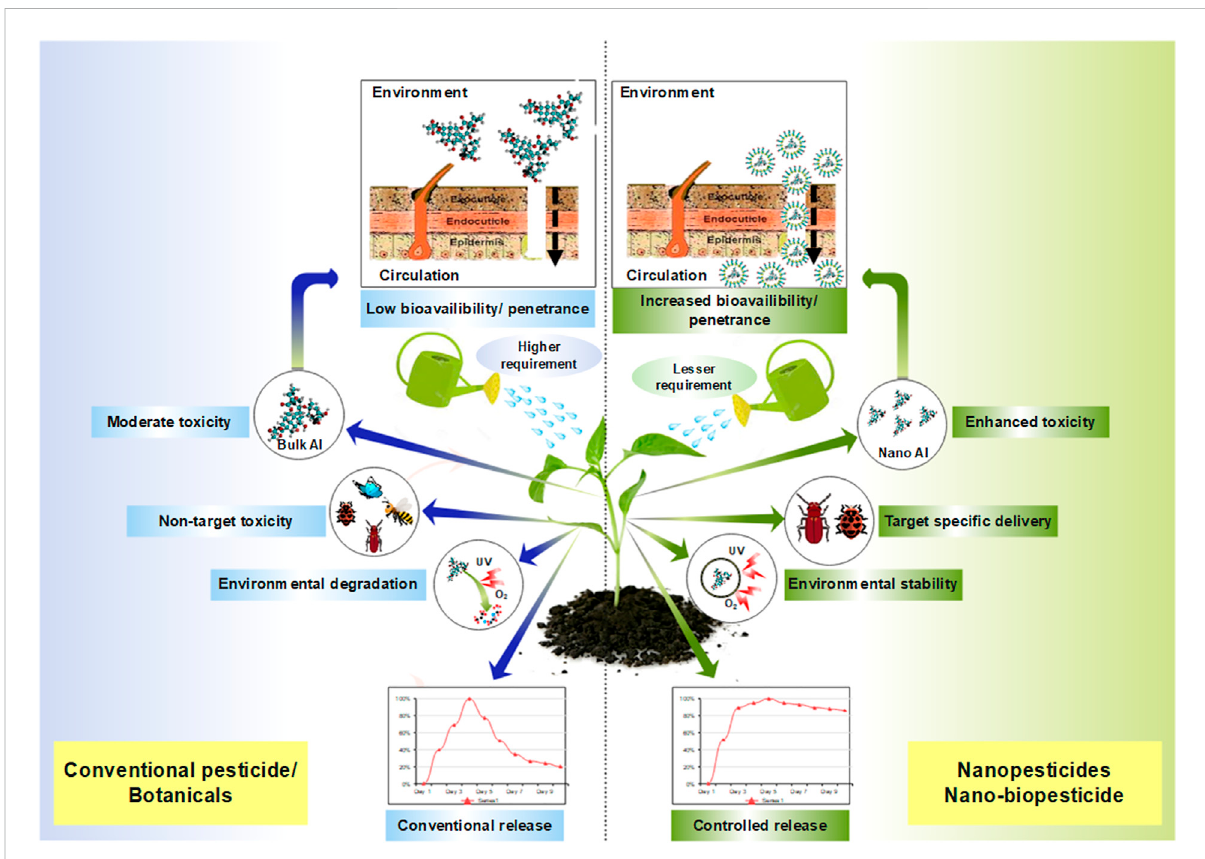
FIGURE 2 An outline depicting superiority of nanopesticides over traditionally used chemical